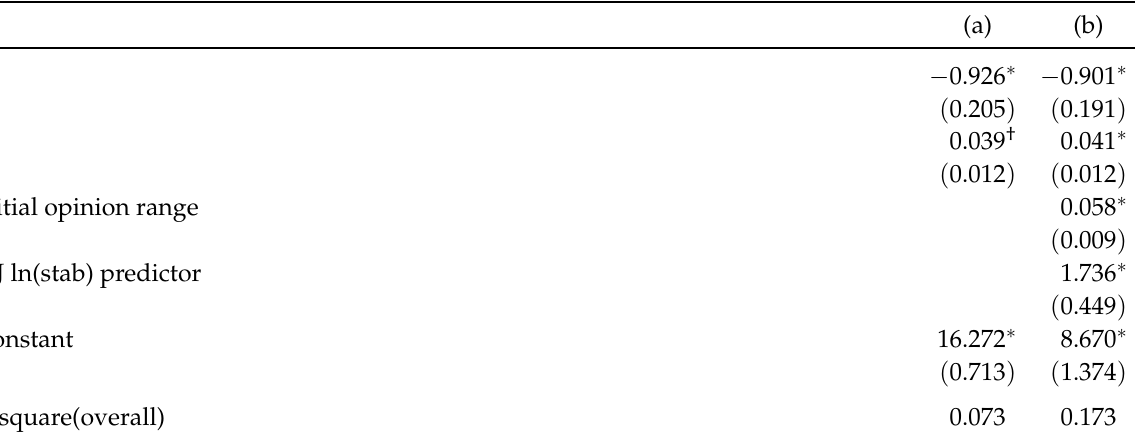
Table4: Evolution of observed time (minutes) to task completion (reaching a state of consensus or irreconcilable disagreement) along the issue sequence s = 1, 2, . . . , 15. Standard errors are in parentheses.